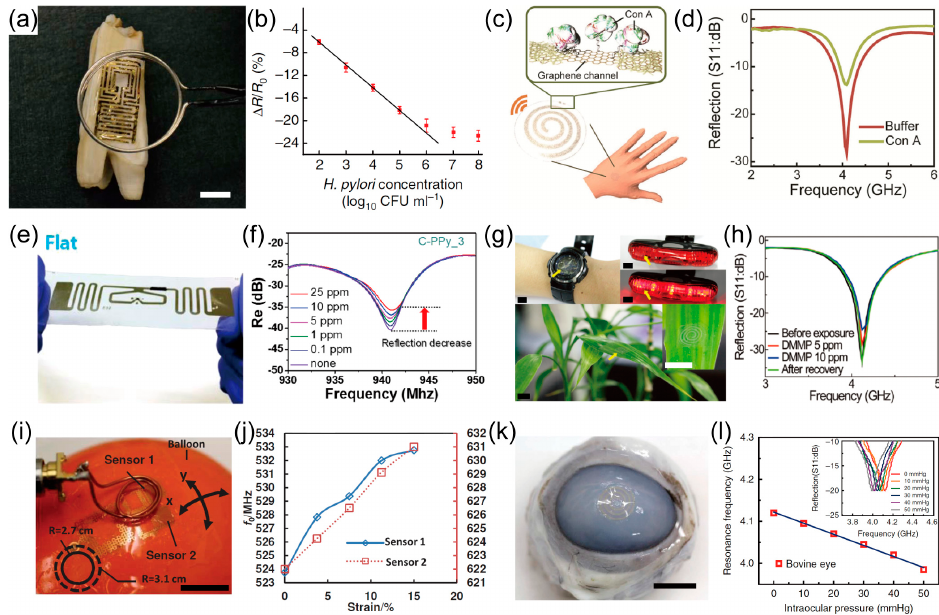
Figure 8. Wearable sensors integrated with resonance antenna. ( a ) Optical image of the graphene-based wireless sensor transferred onto the surface of a tooth (scale bar: 1 cm). ( b ) graphene resistance change versus concentration of H. ( a , b ) Reproduced with permission from Ref. [159]. Copyright 2012, Nature Publishing Group; ( c ) Schematic of the biosensor attached to the skin on the back of a human hand; ( d ) Frequency response of the reflection coefficient of the antenna on the plastic substrates after buffer and Con A treatment. ( c , d ) Reproduced with permission from Ref. [12]. Copyright 2015, John Wiley and Sons; ( e ) Photographs of the RFID tag sensor; ( f ) Change in the reflectance properties. ( e , f ) Reproduced with permission from Ref. [163] Copyright 2016, American Chemical Society. ( g ) Optical photos of wearable gas sensors integrated with resonance antenna transferred onto various substrates (wristwatch, light of bicycle, and a leaf of live plant) (scale bars: 1 cm). ( h ) change in reflection coefficient (S11) of the wireless sensor on the leaf at varied DMMP vapor concentrations (before exposure, 5 ppm of DMMP, 10 ppm of DMMP, and after recovery). ( g , h ) Reproduced with permission from Ref. [18]. Copyright 2016, Royal Society of Chemistry. ( i ) Image of a wireless epidermal sensor attached onto the surface of a balloon to simulate measurement of lymphedema. Scale bar, 1 cm. ( j ) Change in resonance frequencies of strain sensors under the expansion of the balloon. ( i , j ) Reproduced with permission from Ref. [160]. Copyright 2014, John Wiley and Sons. ( k ) Photograph of the sensor transferred onto the contact lens worn by a bovine eyeball. Scale bar, 1 cm. ( l ) Frequency response of the intraocular pressure sensor on the bovine eye from 5 mmHg to 50 mmHg (Inset: the corresponding reflection coefficients of the sensor). ( k , l ) Reproduced with permission from Ref. [32].